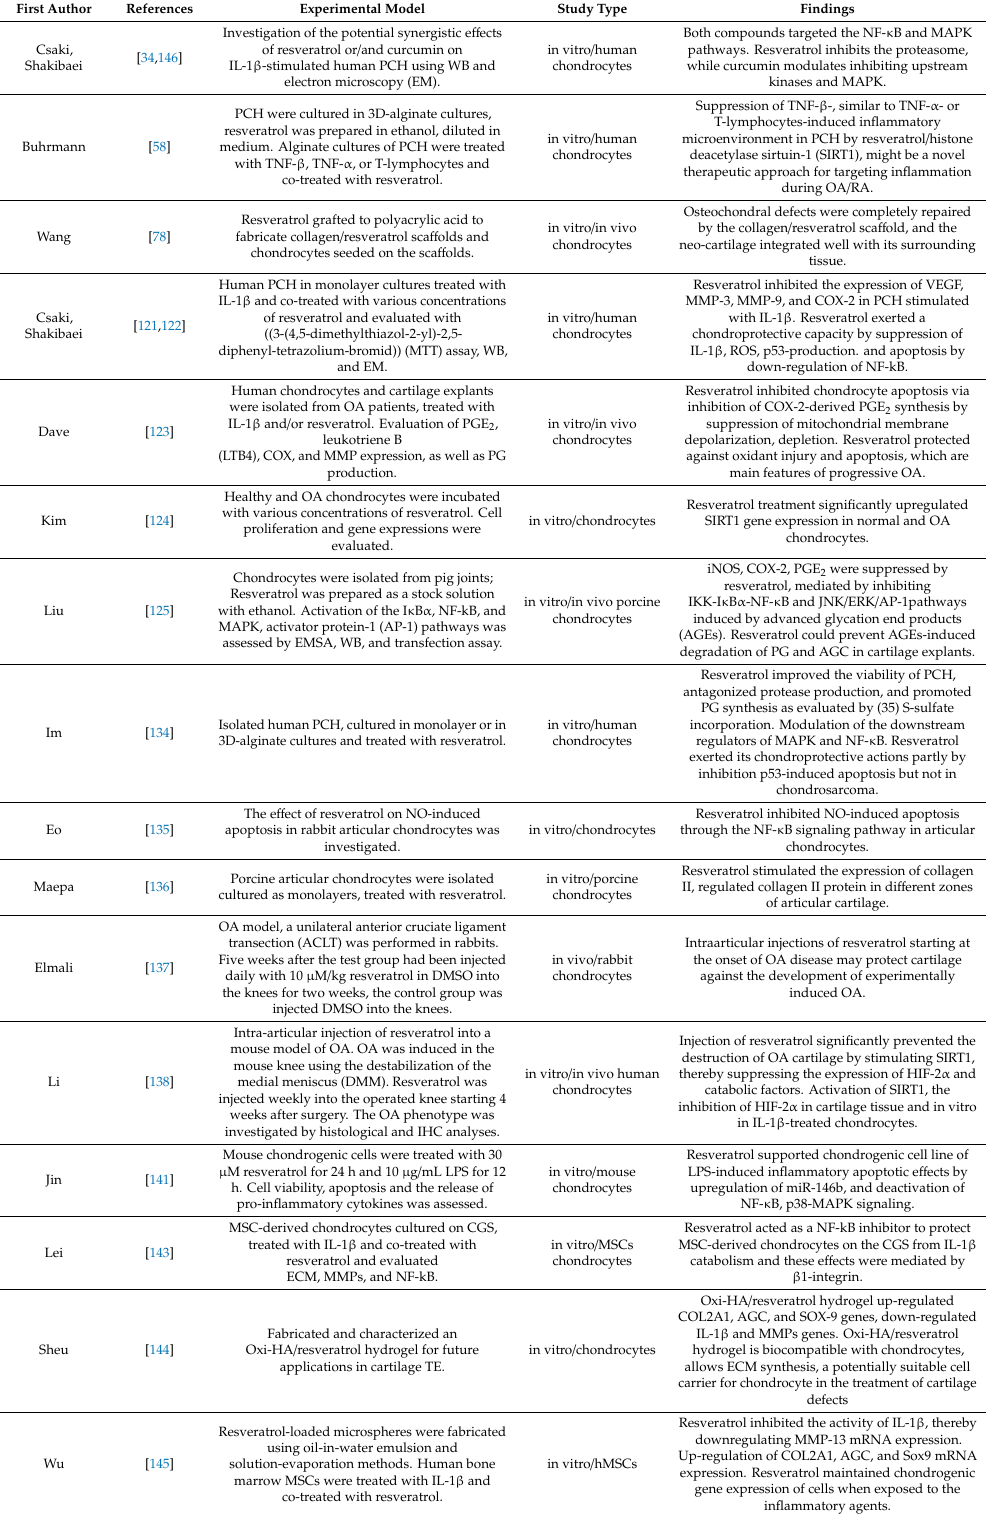
Table 6. Resveratrol application in cartilage tissue